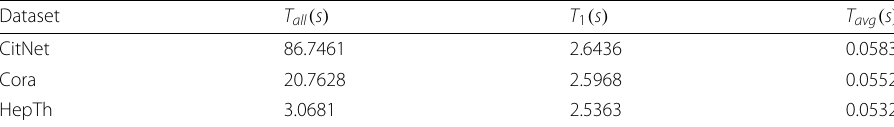
Table 5 Efficiency of SRGAN on the three datasets